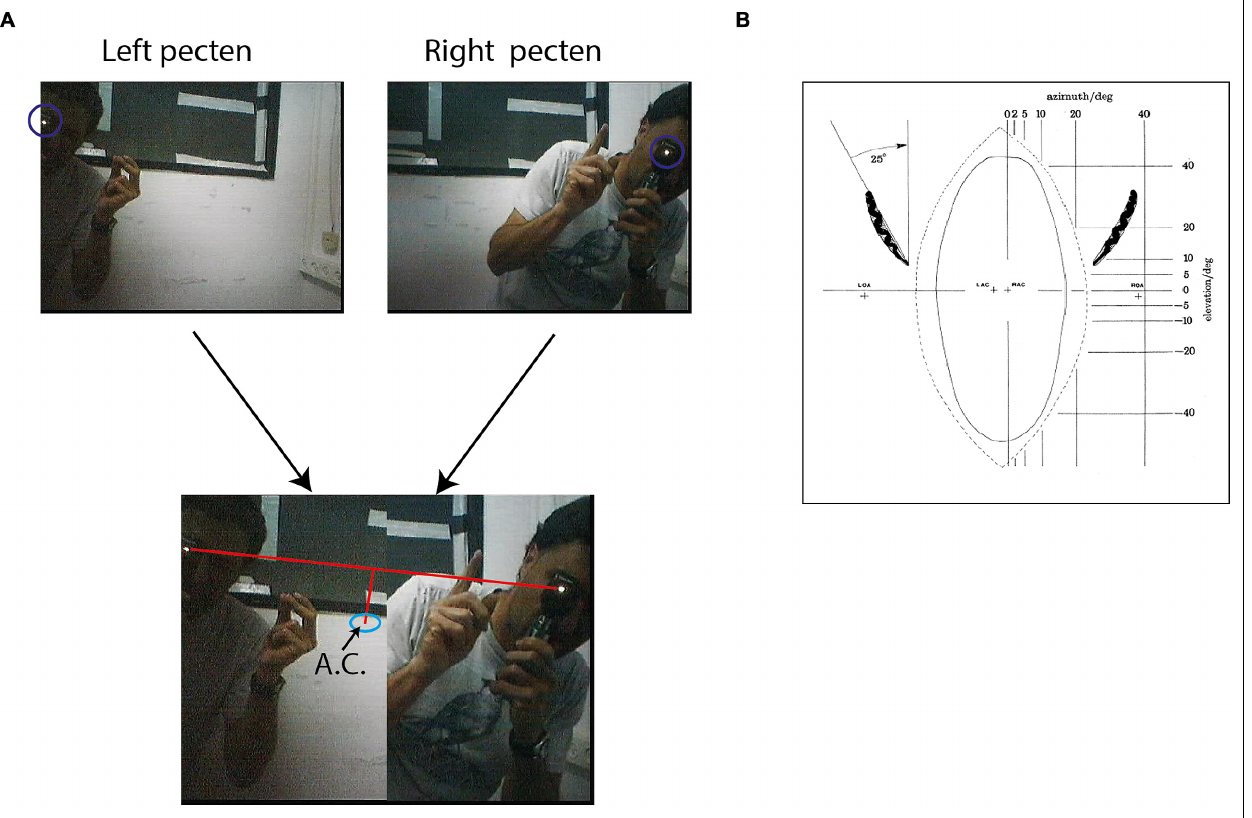
FIGURE 4 | Mapping of area centralis. (A) Two frames from the video sequence are shown above. One frame shows an experimenter standing about 1 m from the owl viewing with an ophthalmoscope the superior tip of the left pected and the second from the experimenter viewing the superior tip of the right pecten.The beam of the ophthalmoscope in both cases is marked by a circle. Below the two half frames are combined to one image. A line is drawn between the two beams and the point that is 7 ◦ below the mid-point of the line is calculated.This point, marked by a circle, is the